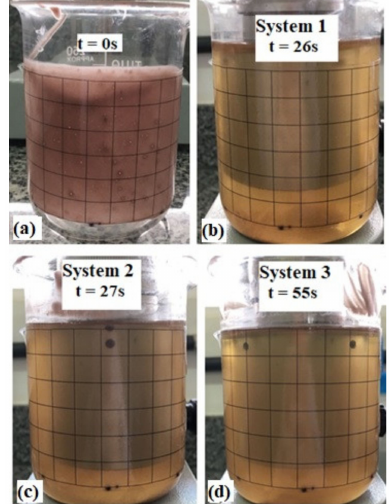
Figure 5. Filter cake removal test: ( a ) thin layer of non-aqueous drilling fluid; ( b ) removal by system 1; ( c ) removal by system 2; ( d ) removal by system 3.